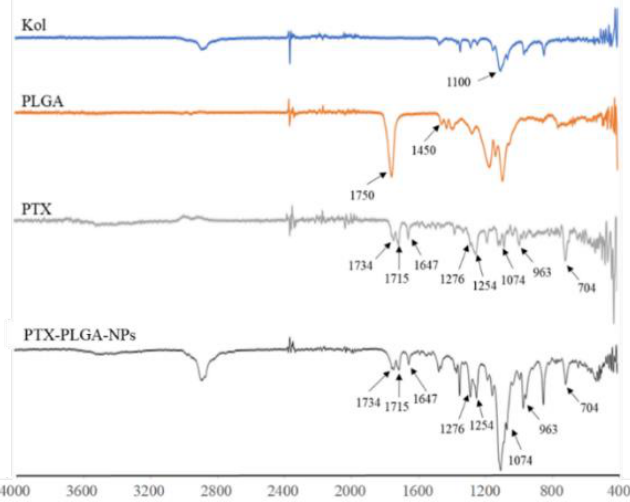
Figure 7. The FT-IR spectra of PTX, PLGA, Kol and optimized PTX-PLGA-NPs. Major IR peaks assigned to PTX were observed at 1734 cm − 1 and 1715 cm − 1 (C=O); 1647 cm –1 (amide bond); 1074 cm − 1 (C–O), 963 cm –1 and 704 cm –1 (aromatic C=C). In addition, bands at 1254 cm – 1 and 1276 cm were attributed to ester bond stretching and C-N stretching vibrations, respectively.